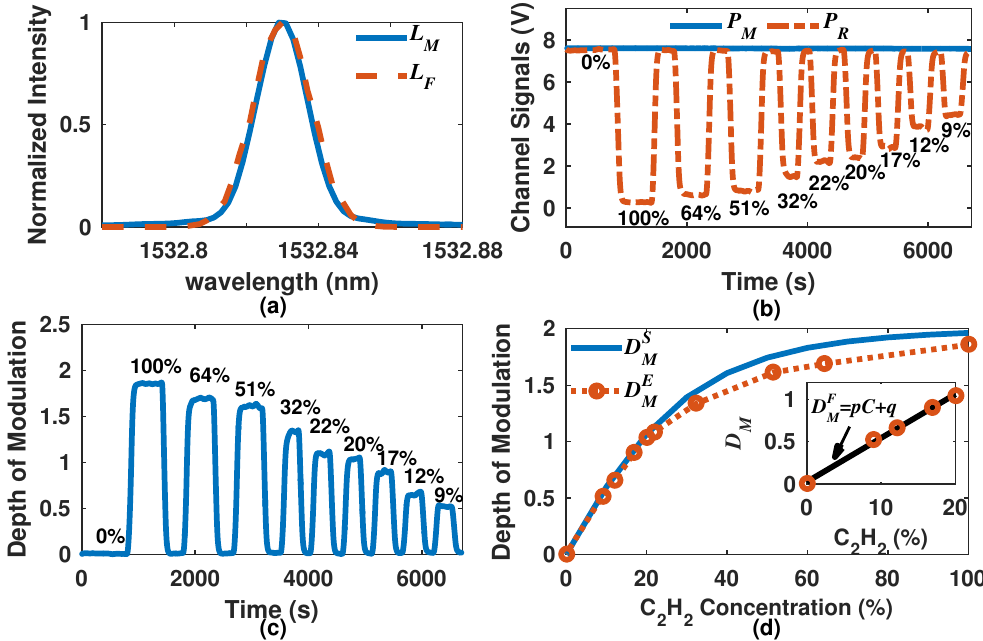
Figure 5. ( a ) Simulated D M error due to wavelength instability and considering different C 2 H 2 concentration; ( b ) Measured temperature variation of the Si wafer over the time and its induced laser wavelength error.